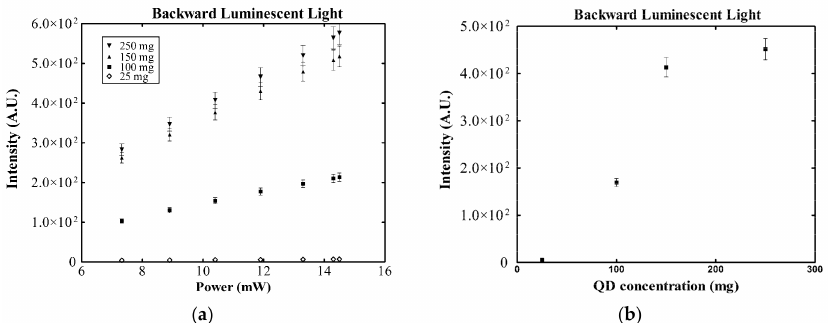
the QDs in the compound films.